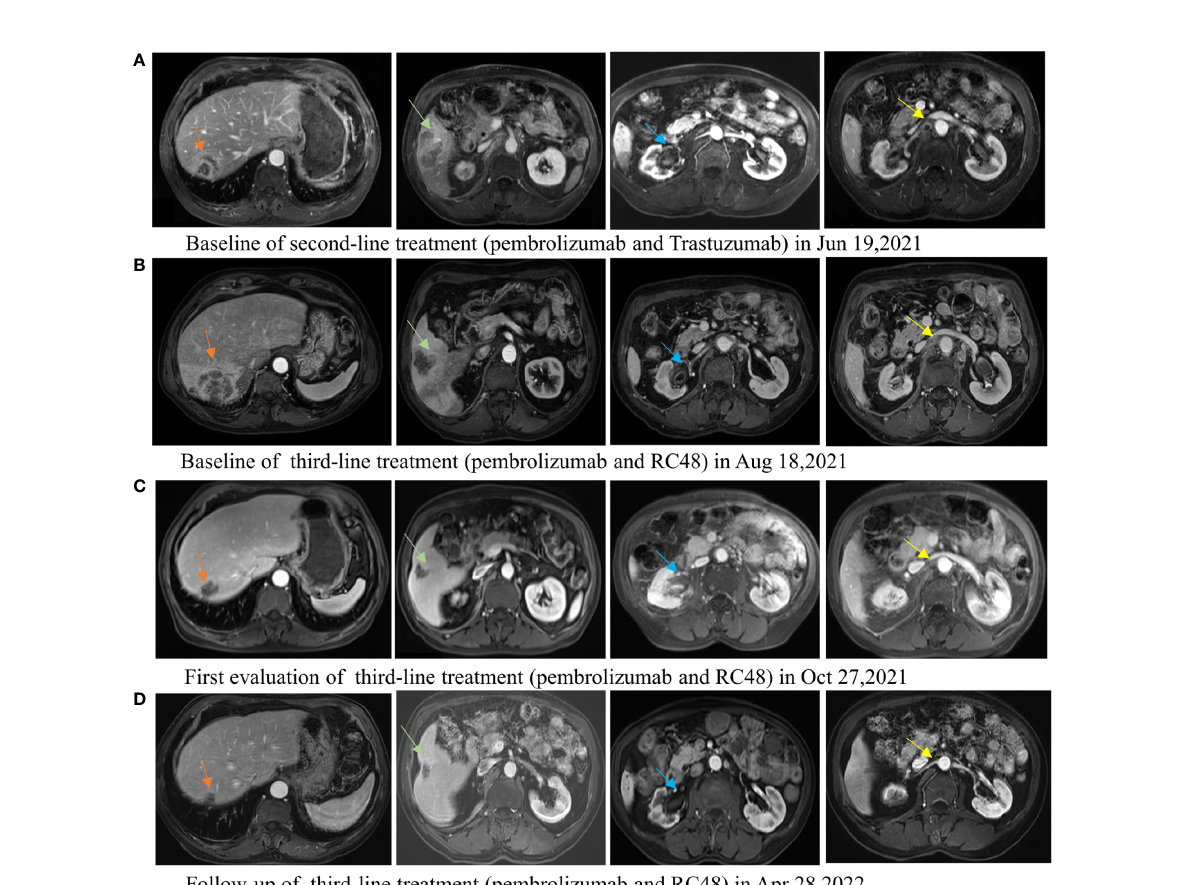
FIGURE 1 Lesions of the liver, ureteropelvic calyces, and lymph node change during the second-line treatment of pembrolizumab combined with trastuzumab and third-line treatment of pembrolizumab combined with RC48. (A) The baseline MRI image of the second-line treatment. (B) The image of tumor progression after second-line treatment, and the baseline image of the third-line treatment. The hepatic metastasis in the right posterior upper lobe was signi fi cantly enlarged and the other lesions reduced after second-line treatment. (C) The fi rst ef fi cacy evaluation after third-line treatment for 2 months: partial response. All tumor foci are reduced. (D) The image evaluation after third-line treatment for 8 months: partial